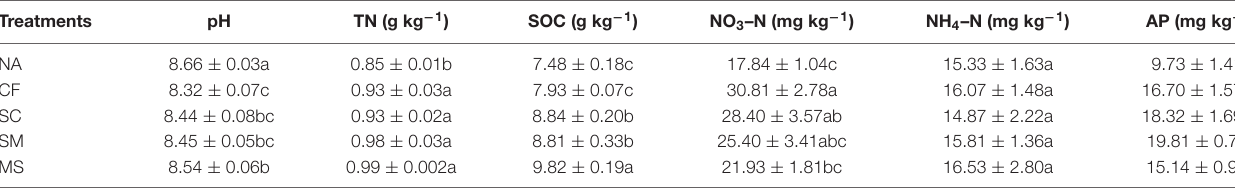
TABLE 1 | Soil chemical properties at the flowering stage of maize under five treatments. Treatments